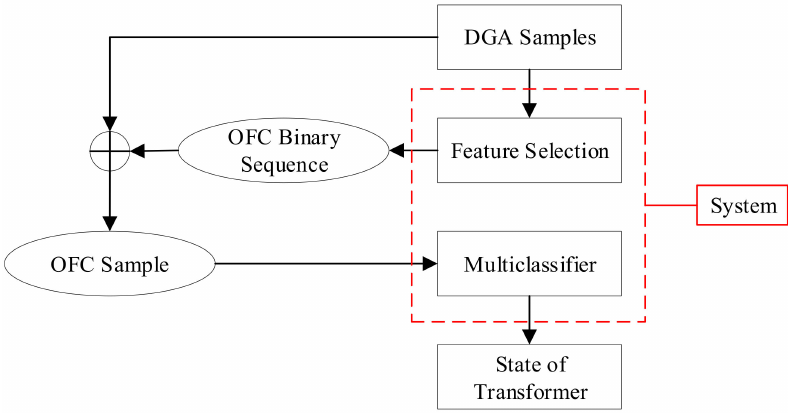
Figure 1. The structure of the diagnostic system.